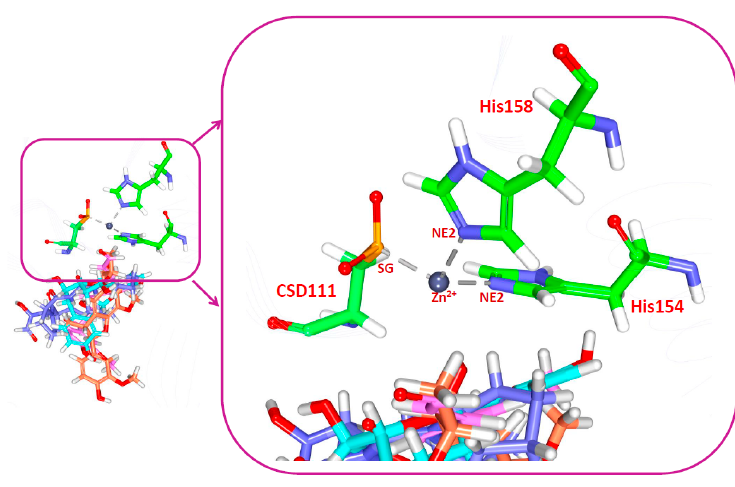
Figure 9. Stable triad metal ion interaction. Table 8. Tabulation of the dock scores of reference and the hits employing two different approaches.